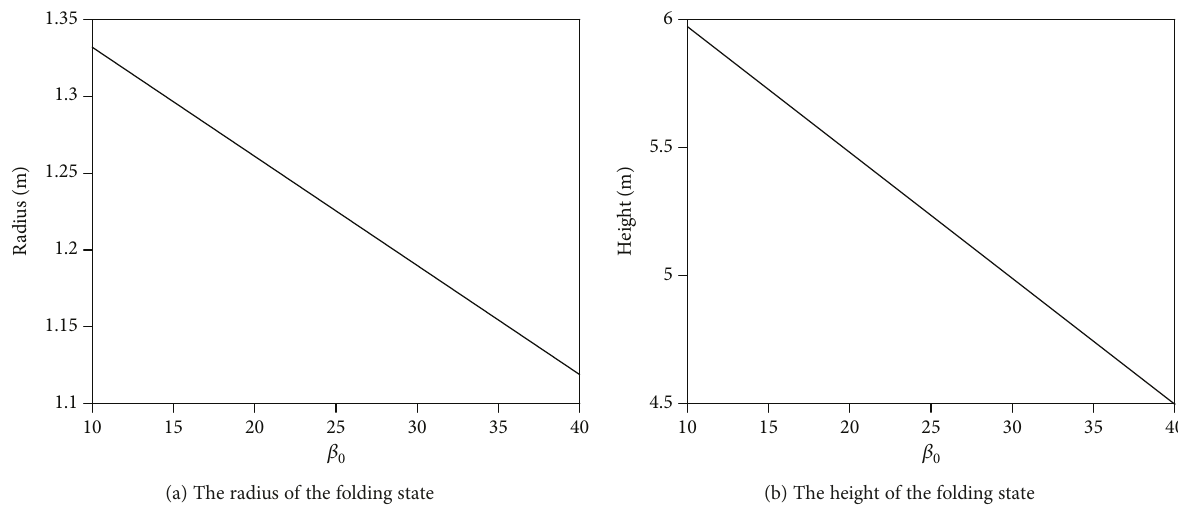
Figure 13: Relationship curve between the initial values of the angle and the folding states.